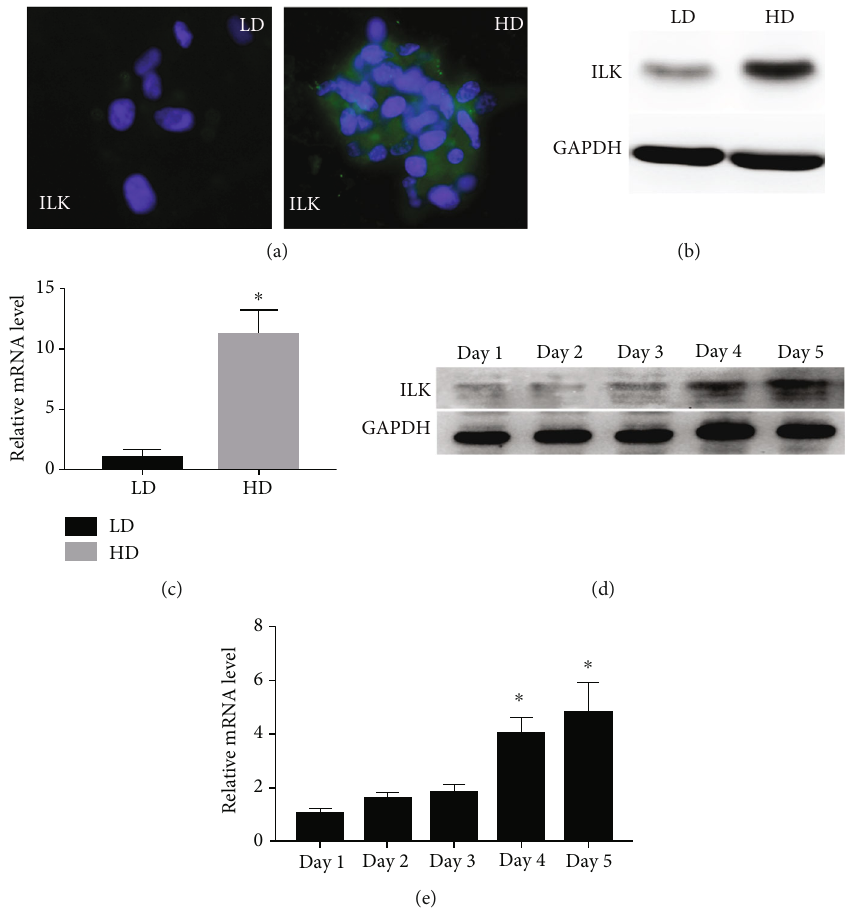
Figure 2: (a – e) High cell density culture increased ILK expression. Immunostaining for ILK in high density (HD) and low density (LD) cultures (a). Western blot and qRT-PCR for ILK were quanti fi ed to show relative protein and mRNA levels in LD and HD USCs, respectively (b, c). Expression of ILK proteins and mRNA levels over a period of 5 days was evaluated by Western blot and qRT-PCR (d,